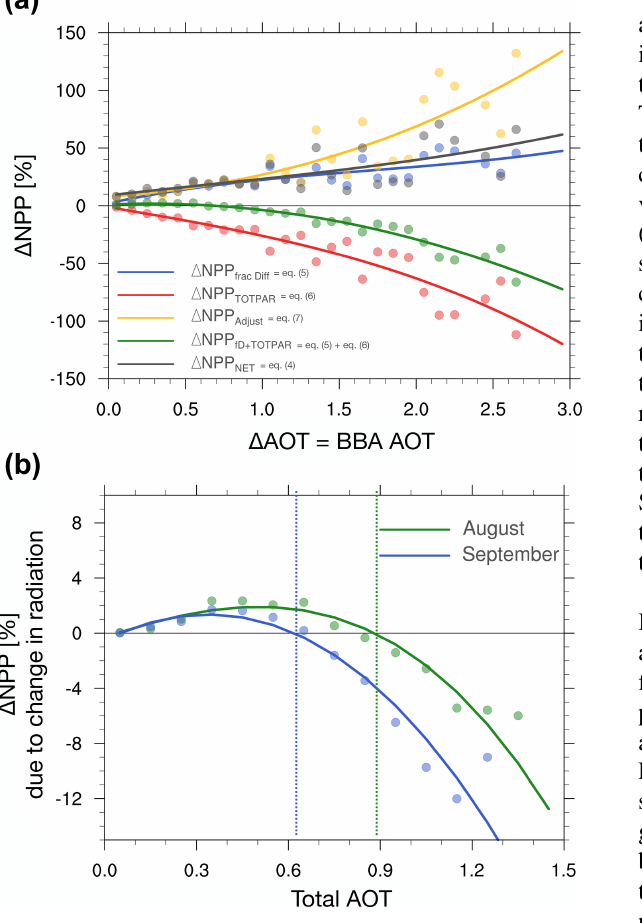
Figure 8. Shown on panel (a) the relative changes in NPP ( (cid:49) NPP Net , in grey), the relative changes in NPP due to the change in diffuse fraction ( (cid:49) NPP FracDiff , in blue), reduction in total PAR ( (cid:49) NPP TOTPAR , in red), the sum of change in diffuse fraction and reduction in total PAR ( (cid:49) NPP f , in green, i.e. the d + TOTPAR DFE), and the climate feedback ( (cid:49) NPP Adjust , in yellow) against the anomalies in the AOT at 550nm for the month of August. Shown on panel (b) the relative changes in NPP due to change in diffuse fraction and reduction in total PAR ( (cid:49) NPP f ) – i.e. d + TOTPAR = DFE the changes in NPP only due to change in surface radiation, the DFE, for August (green) and September (blue) as a function of the total AOT at 550nm. Note this is shown against the total AOT. The dashed lines on panel (b) highlight the AOT thresholds where the DFE switches from a positive to a negative